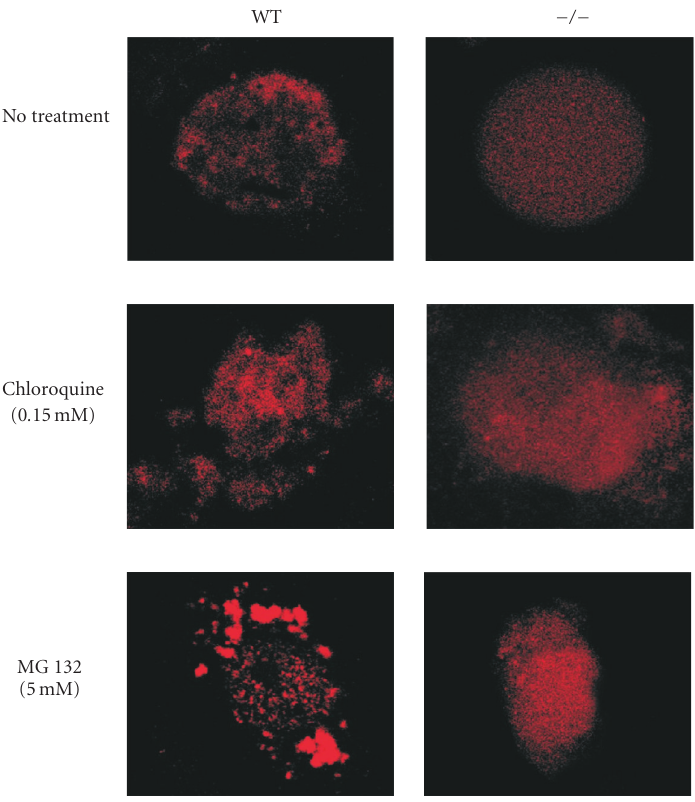
Figure 10: Mouse embryo fibroblasts (MEF) from wild type (WT) or p62 − / − mice were treated with chloroquine or MG132 as shown. After 24 hours, the cells were fixed and stained with primary antibody to ubiquitin and secondary antibody to Texas